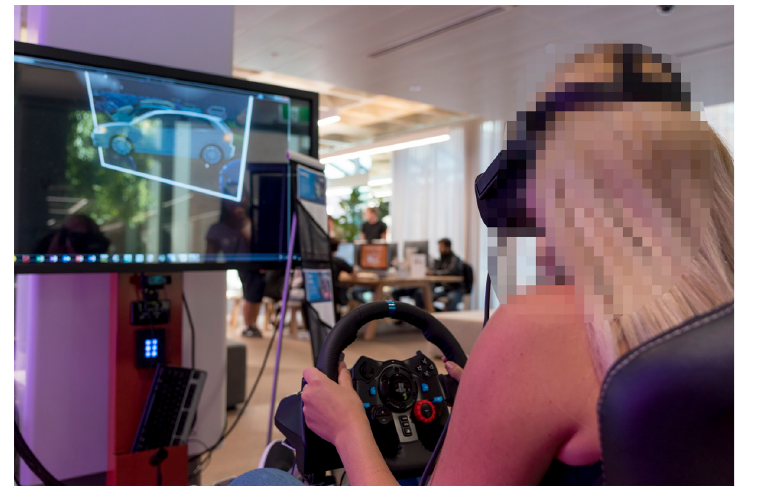
Fig 4. The VR software visualises parking of the vehicle before entering the night club.